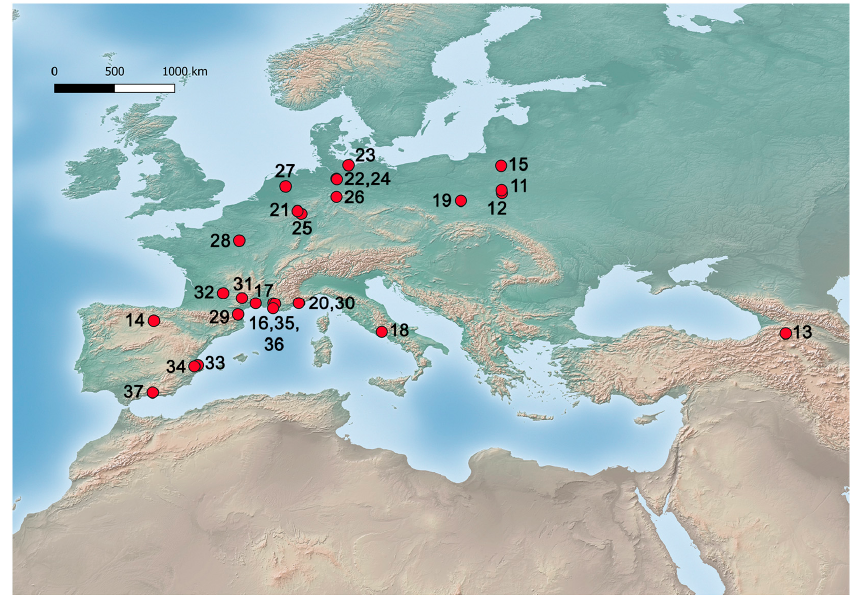
Figure 4. Middle Pleistocene sites where Celtis remains were reported (numbers in the figure corre- spond to ID numbers in Table 2) (map generated using QGIS version 3.4.13; Source: Natural Earth